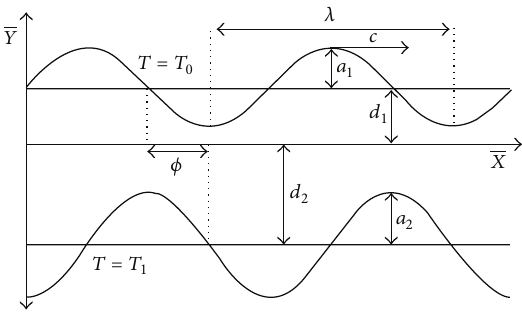
Figure 1: Sketch of the physical model.